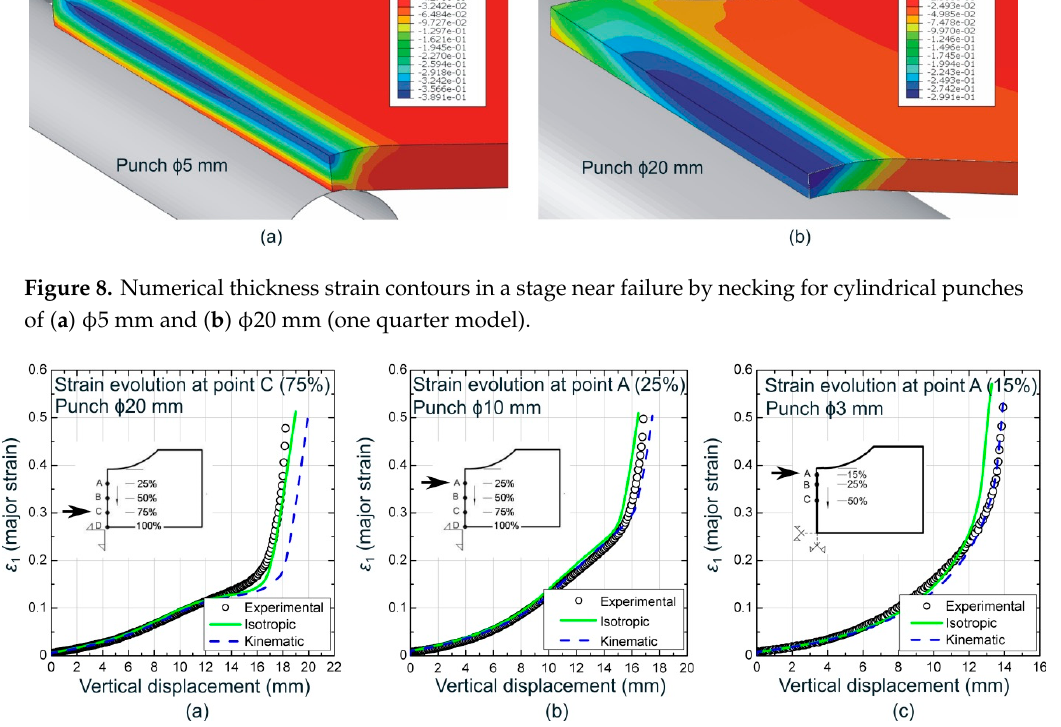
Figure 9. Experimental and numerical prediction of major strain at the outer surface versus vertical displacement for cylindrical punches of ( a ) φ 20 mm, ( b ) φ 10 mm, and ( c ) φ 3 mm (one quarter model). Finally, the evolutions of the punch force versus punch travel were also compared. As shown in